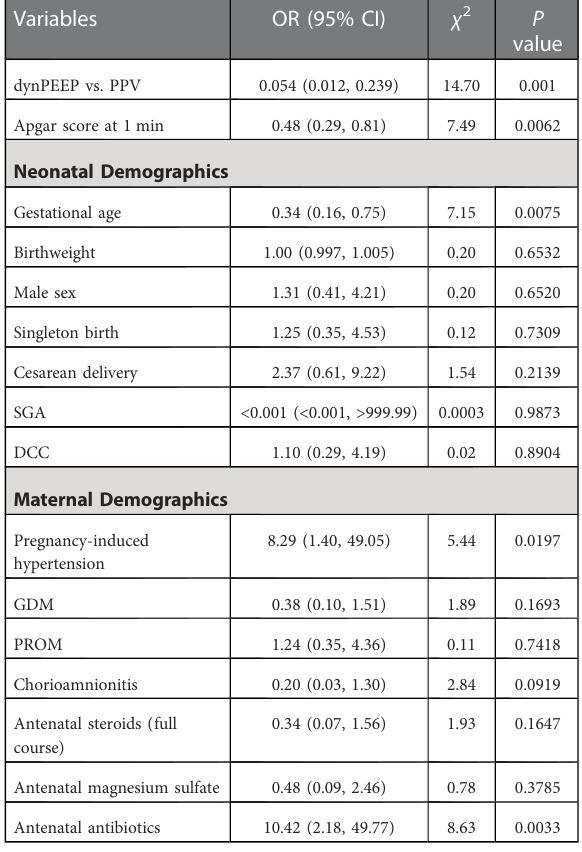
OR, odds ratio; CI, con fi dence interval; SGA, Small for gestational age; DCC, delayed cord clamping; GDM, gestational diabetes mellitus; ICP, intrahepatic cholestasis of pregnancy; PROM, premature rupture of membranes; PPV, positive pressure ventilation; dynPEEP, dynamic positive end